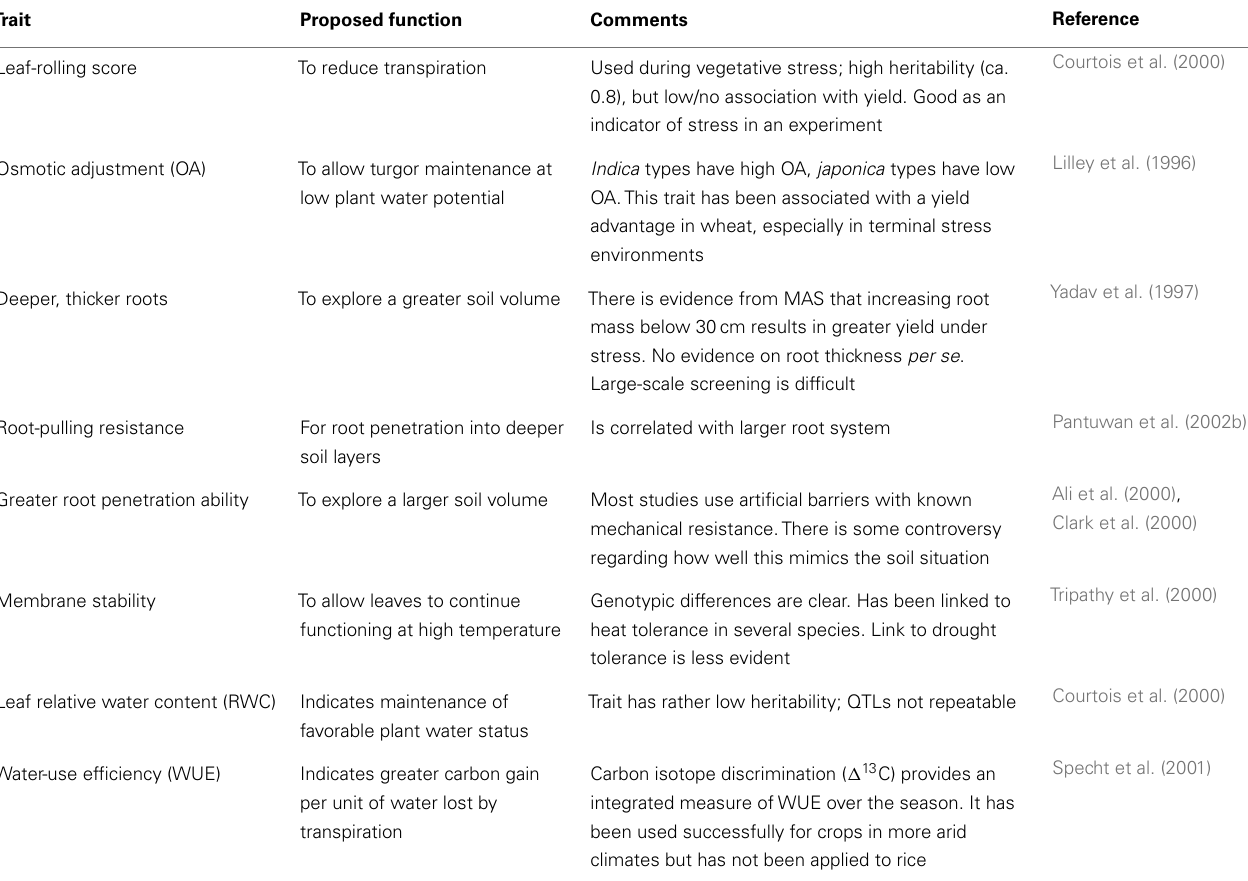
Table 4 | Putative traits for drought